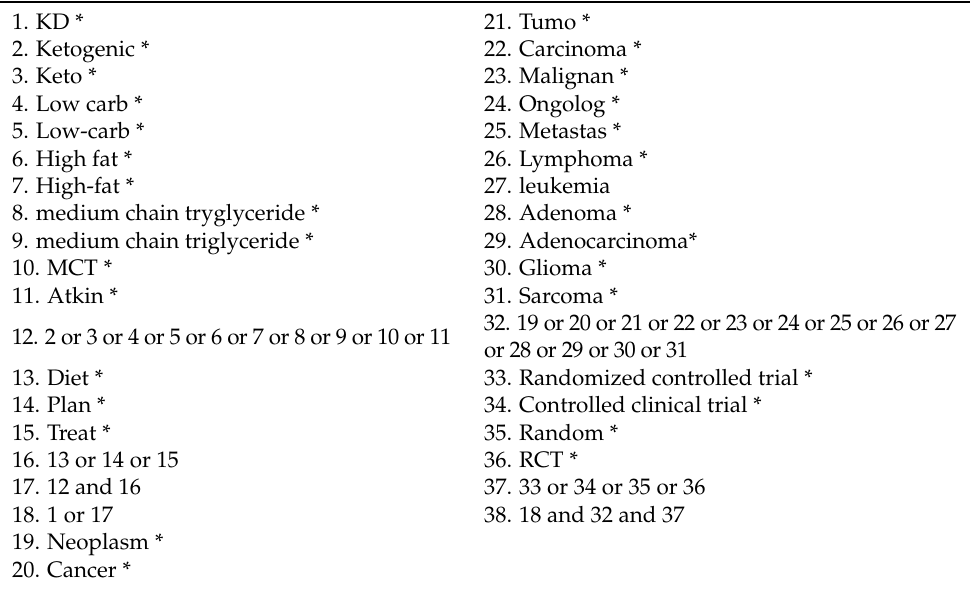
Table 2. Search terms used to identify articles related to ketogenic diet or related to human